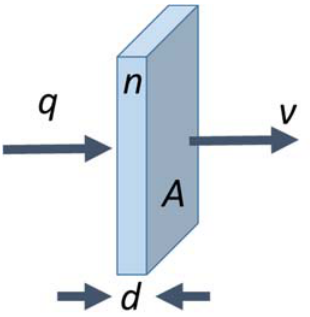
Figure 2. A schematic diagram for modeling the smoke dynamics. The sensor is assumed to be placed on the left face of the vertical imaginary box. Incoming smoke flux q and propagation direction v are shown by arrows.